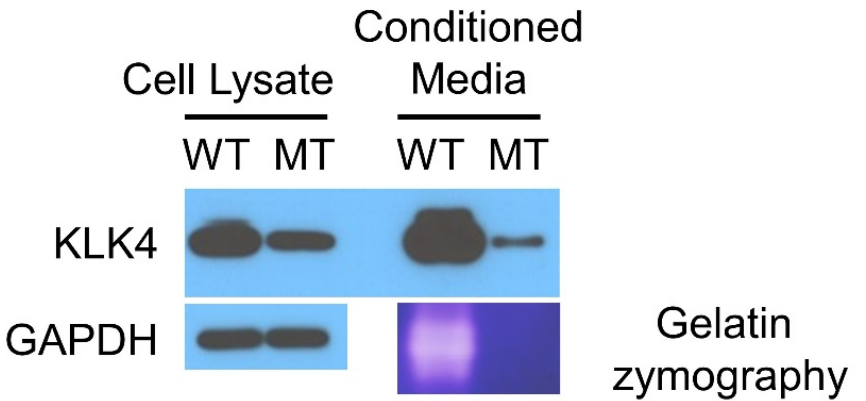
Figure 4. Western blot of the cell lysate and conditioned media. The names of the antibodies used are listed on the left. Gelatin zymography showed the loss of proteolytic function for mutant KLK4. WT, wild type sample transfected with normal KLK4 pcDNA3.1 vector; MT, mutant sample transfected with mutant KLK4 pcDNA3.1 vector. Table 1. Disease-causing mutations in KLK4 gene.